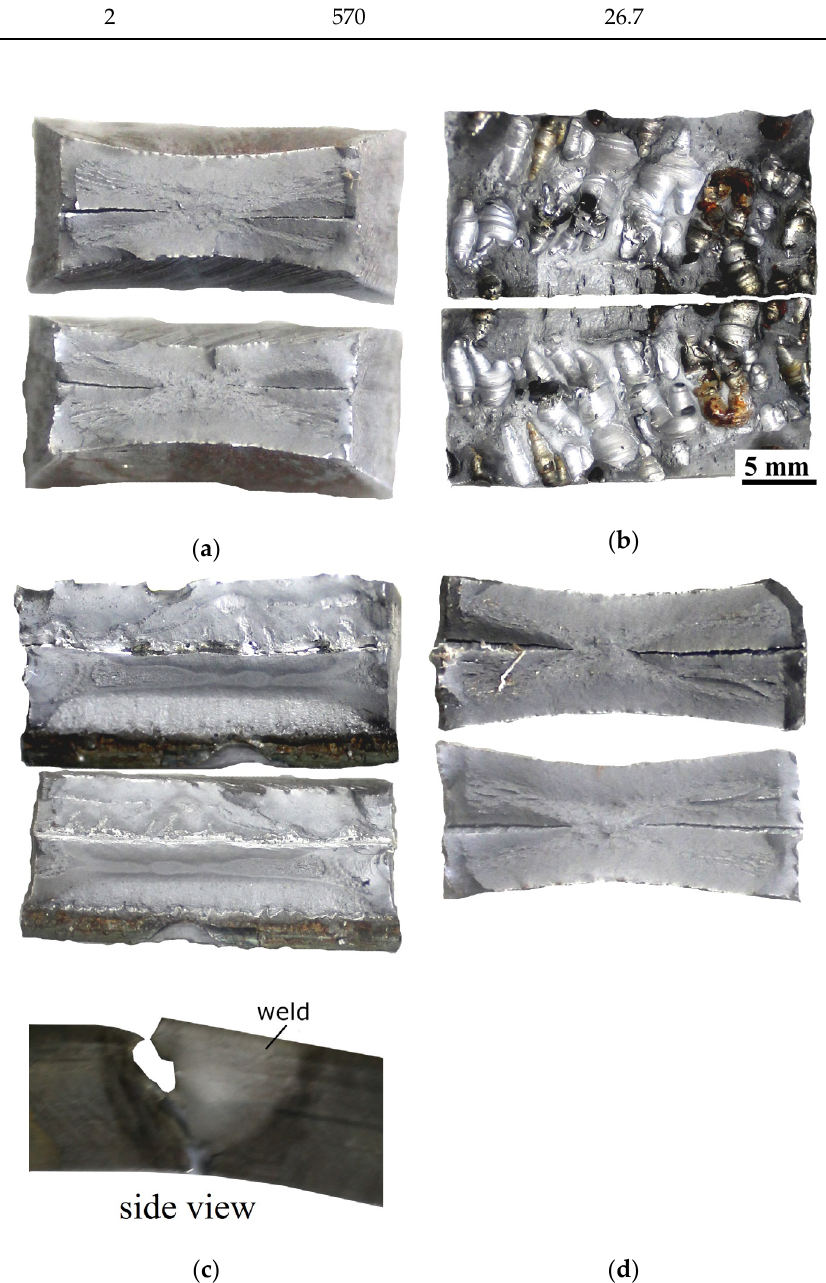
Figure 11. The fracture surface of the broken area during tensile testing: ( a ) Sample 1 from specimen SW, broken in base material (BM); ( b ) Sample 2 from specimen SW, broken in the weld; ( c ) Sample 1 from specimen SA, broken in the fusion line; and ( d ) Sample 2 from specimen SA, broken in the BM.